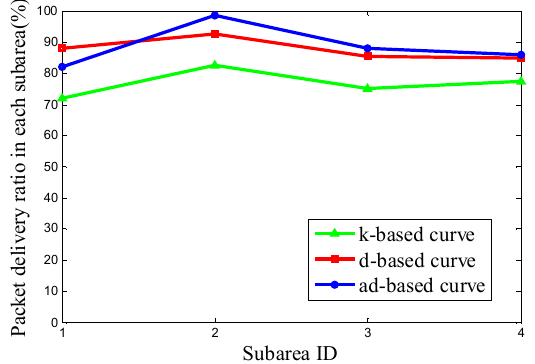
Figure 20. The PDR of k-based, d-based and adjustable d-based curve in node deployment (c): C 1 is deployed with 50 nodes, C 2 is deployed with 150 nodes, C 3 and C 4 are deployed with 300 nodes.